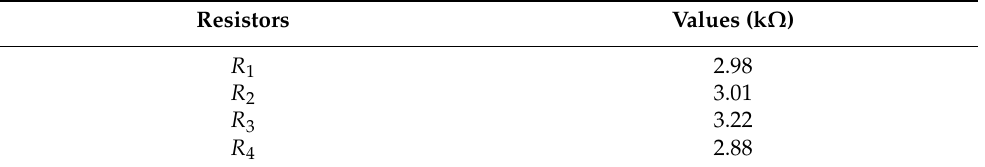
Table 3. Resistance of gauges under no load.